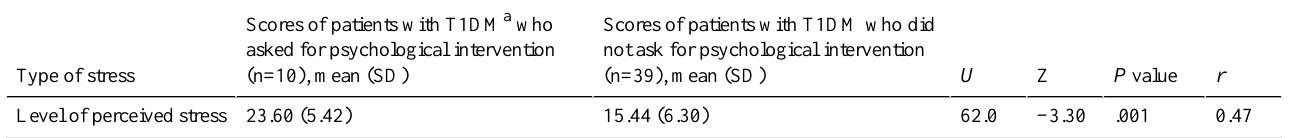
Table 2. Level of stress in the examined groups.